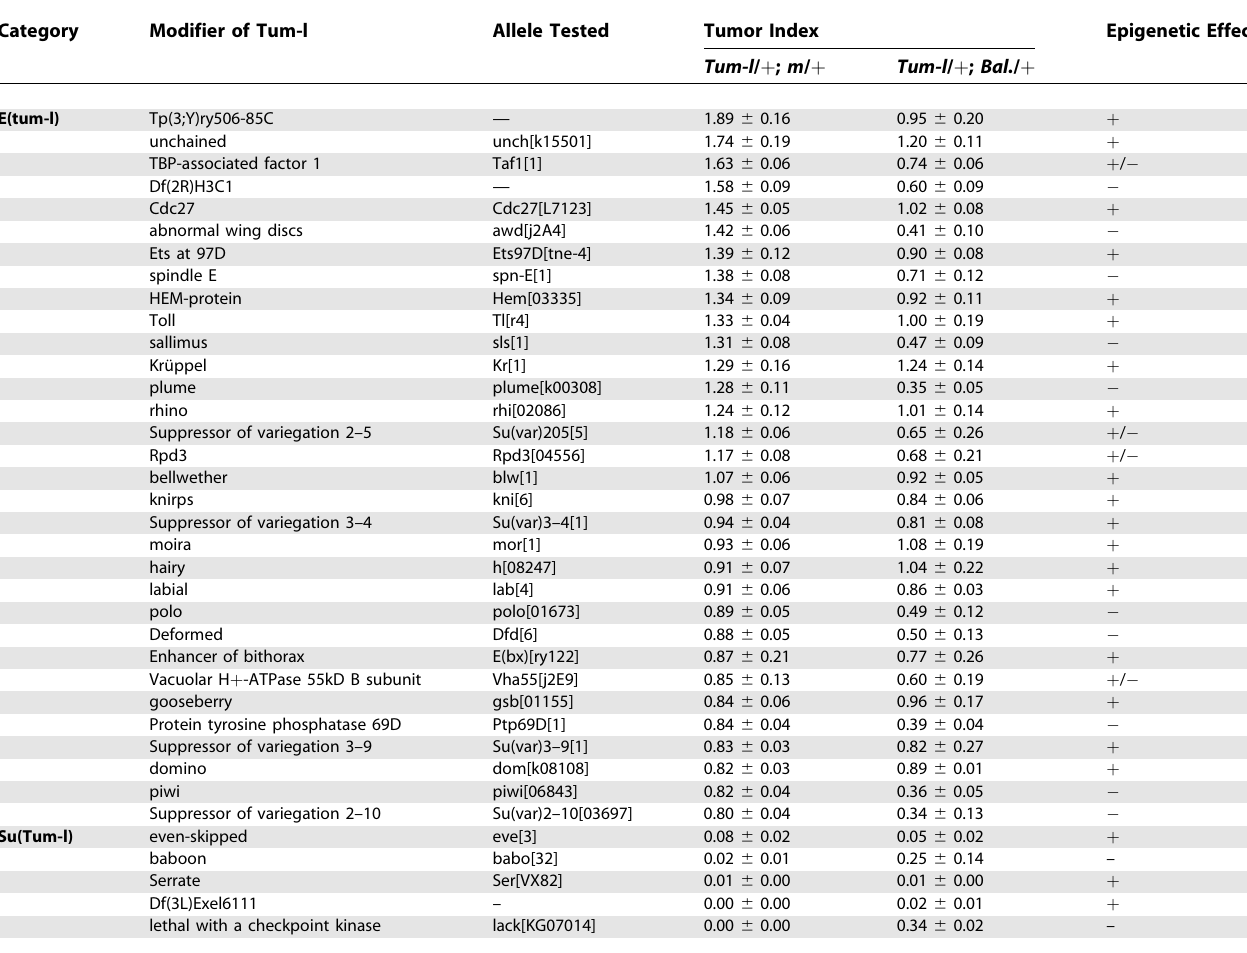
Table 1. Genetic and Epigenetic Modification of hopTum-l Tumorigenicity Category Modifier of Tum-l Allele Tested Tumor